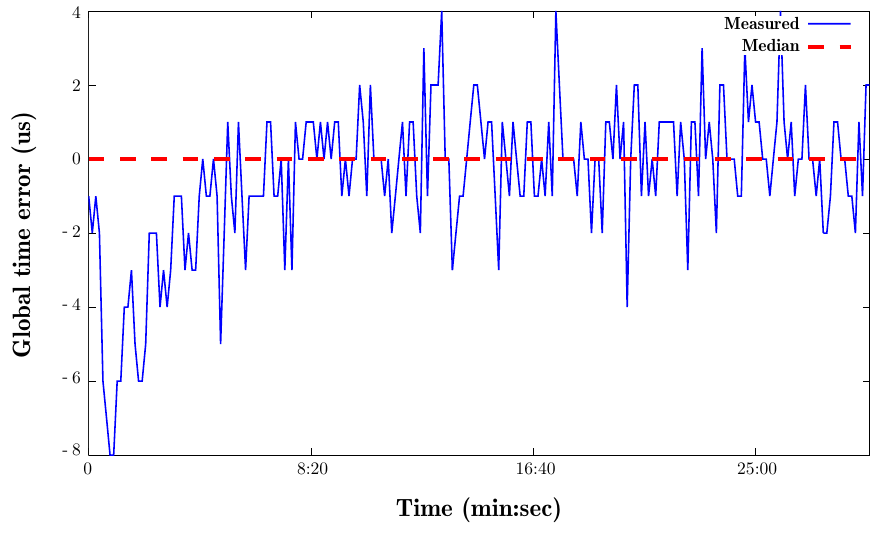
Figure 6. Consequences of clock drift.